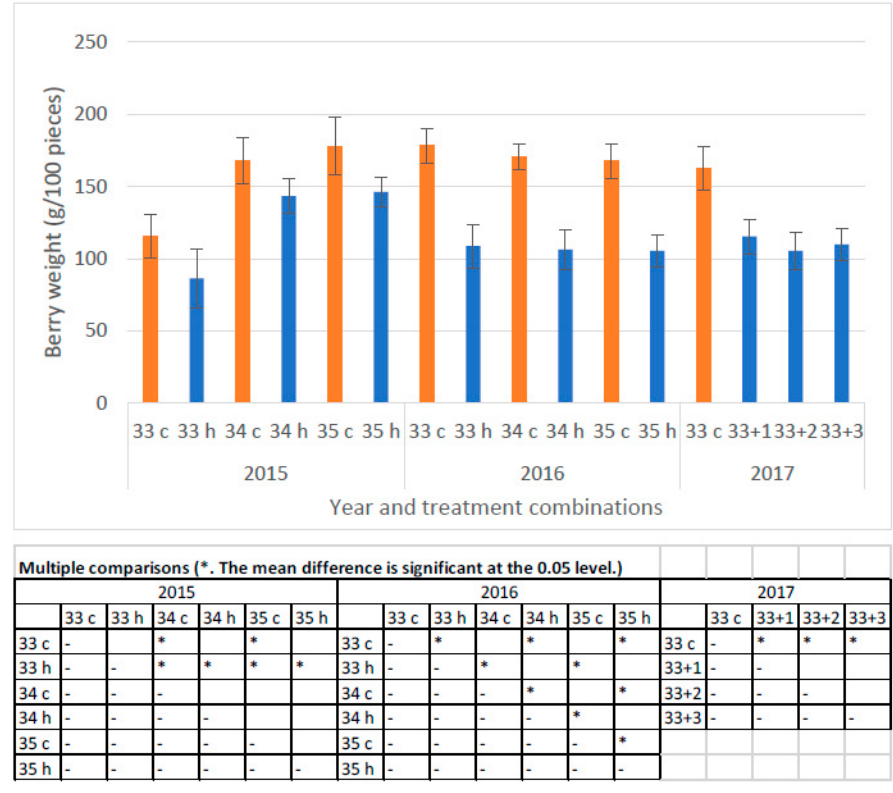
Figure 2. The effect of the different DMR treatments on the berry weight (g/100 pieces).